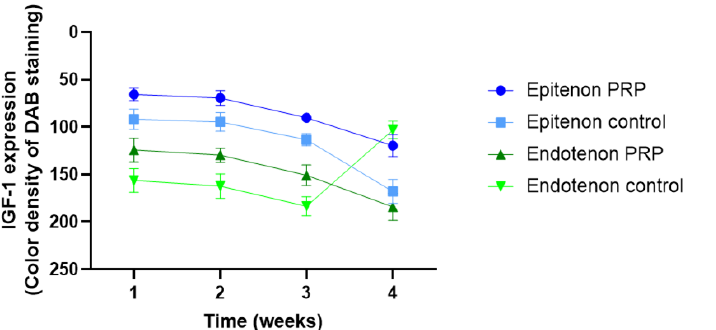
Figure 12. IGF-1 expression as a function of time in epitenon and endotenon for PRP treated specimen and control. Values are based on Table 1 in reference [135]. High IGF-1 expression corresponds to low color density values. Lower color density values were attributed to higher brown intensity, whereas higher color density values corresponded to lower brown content.